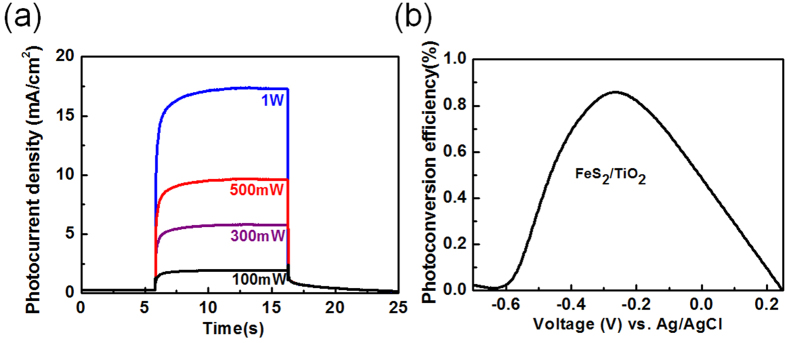
(a) The dependence of photocurrent of the FeS2/TiO2 photoanode operated at a bias of 0.1 V as a function of incident power under excitation with an 808 nm laser. (b) The photoconversion efficiency () curves for the FeS2/TiO2 photoanode.